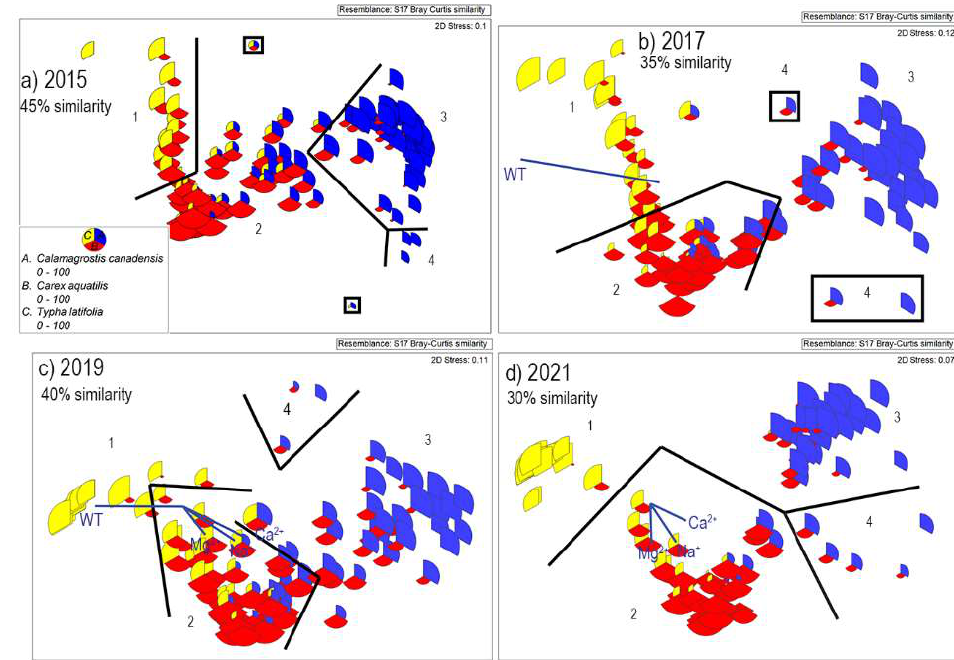
Figure 1. NMDS ordinations of vegetation plots sampled in ( a ) 2015, ( b ) 2017, ( c ) 2019, and ( d ) 2021. Clusters of plots recognized as plant communities (1–3) divided by black lines, 4 = outlier plots. Abundance of dominant species in individual plots shown by segmented bubbles across the ordination— Typha latifolia (yellow), Carex aquatilis (red), and Calamagrostis canadensis (blue). Significant environmental gradients plotted as vectors (blue lines). DTW = distance of the water table from soil surface; water tables increase above the soil surface to the left, water tables increase below the soil surface to the right; Ca 2+ , Mg 2+ , and Na + concentrations increase to the lower right. Plant community 1 consists of plots having high abundances of Typha latifolia , with Carex aquatilis and Utricularia minor occurring in low abundances. Overall, these plots are